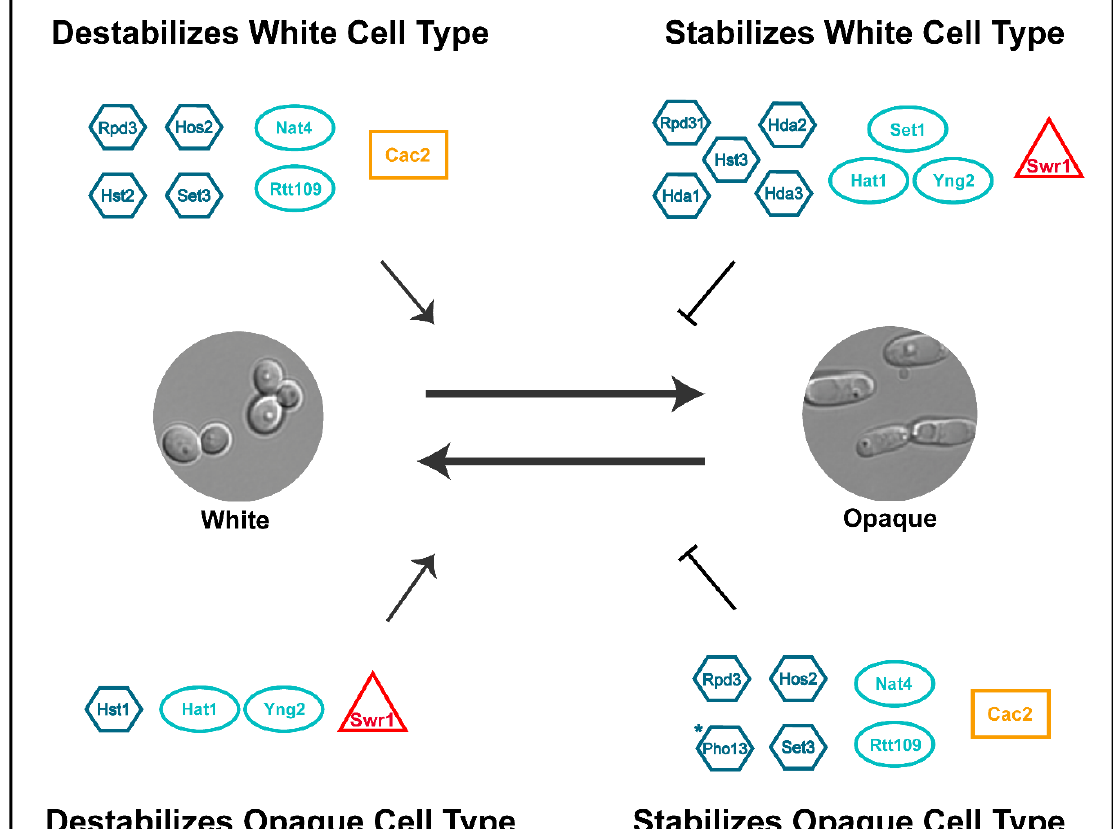
Figure 2. Roles of chromatin modifying enzymes in regulating the C. albicans white-opaque switch. White to opaque and opaque to white switching is indicated by the central black arrows. Smaller black arrows indicate proteins that act to promote switching in the white to opaque direction (upper left quadrant) or in the opaque to white direction (lower left quadrant), while black lines with crossbar indicate proteins that repress switching in the white to opaque direction (upper right quadrant) or in the opaque to white direction (lower right quadrant). Erasers are shown as blue hexagons, writers are shown as aqua ovals, chromatin remodelers are shown as red triangles, and histone chaperones are shown as orange rectangles. Note that Yng2 is a subunit of the NuA4 complex and that Cac2 is a subunit of the CAF-1 complex. *Pho13 has been shown to lack protein phosphatase activity and is instead involved in metabolism [159,160].